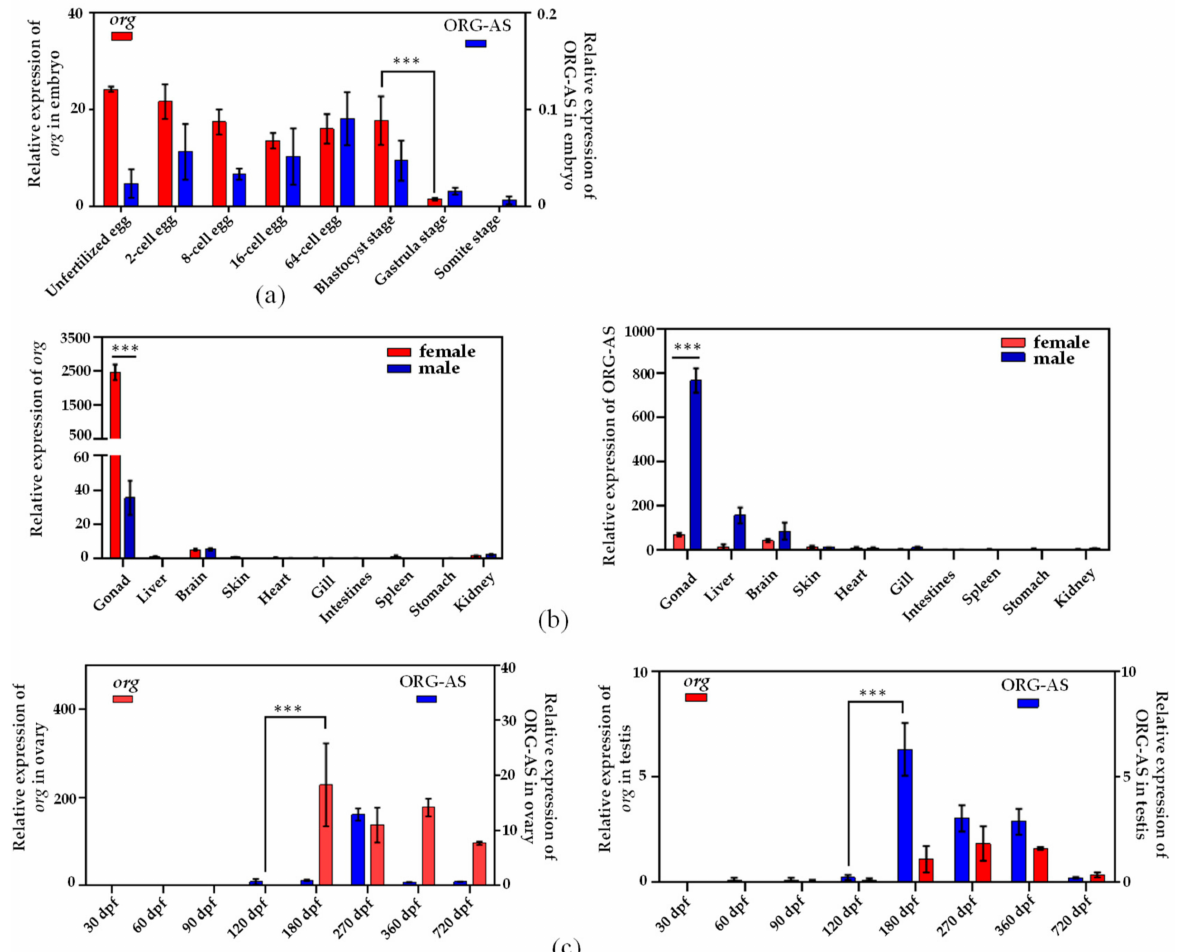
Figure 4. Expression of org and ORG-AS in C. semilaevis . ( a ) org and ORG-AS expression patterns in early embryos, and org and ORG-AS expression levels normalized to 18S rRNA expression; ( b ) Expression of org and ORG-AS in sexually mature C. semilaevis , and org and ORG-AS expression levels normalized to β -actin expression; ( c ) Expression patterns of org and ORG-AS during gonad development in C. semilaevis , and org and ORG-AS expression levels normalized to β -actin expression. The mean ± SEM from three independent individuals ( n = 3) is shown. (*** p <